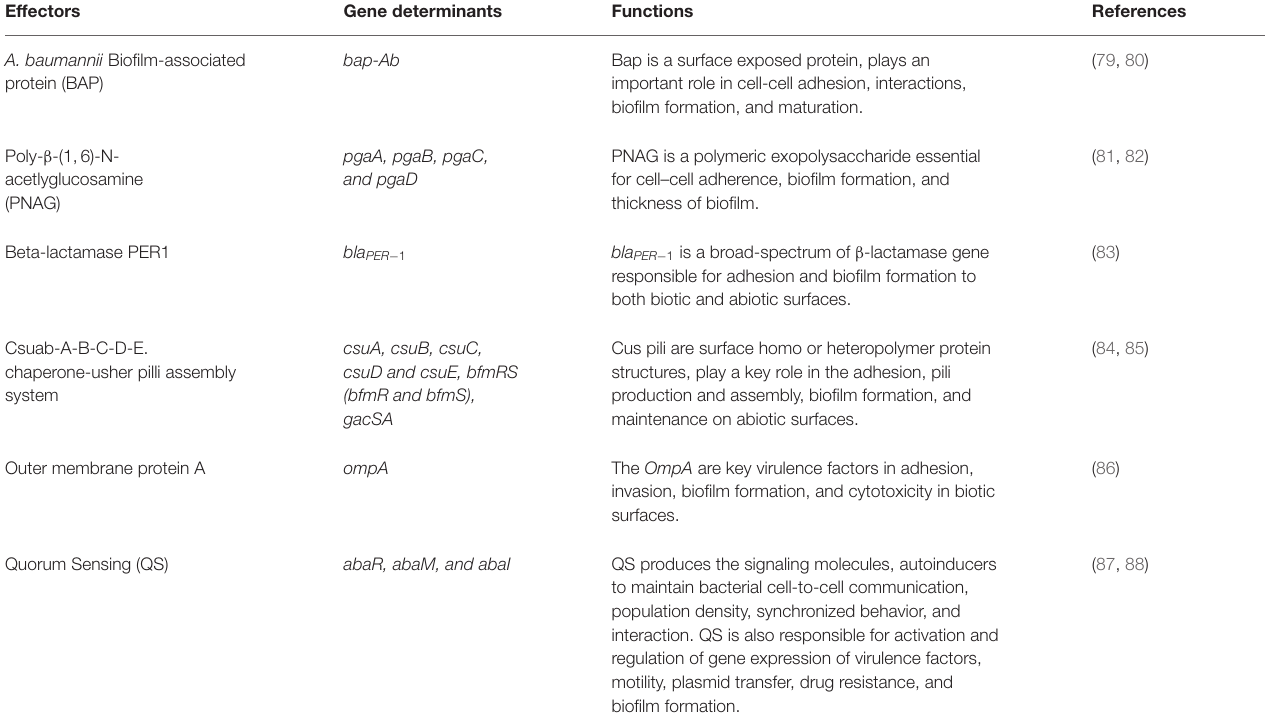
TABLE 1 | Factors implicated in Acinetobacter baumannii biofilm formation and